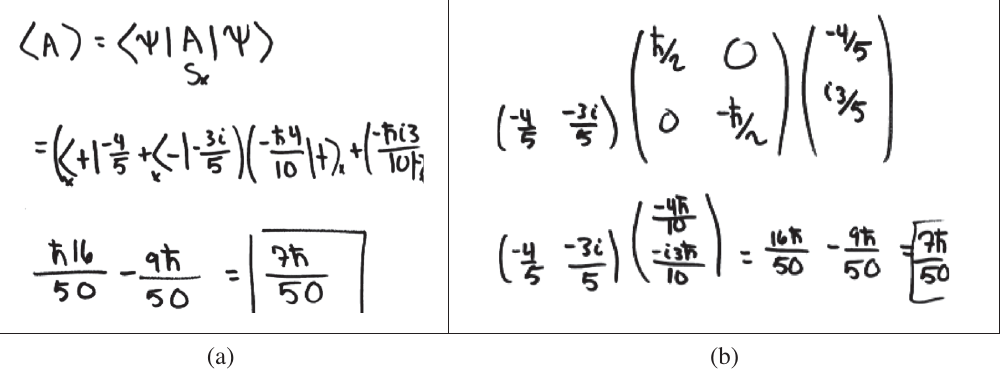
FIG. 3. Buzz ’ s expectation value problem work, in Dirac notation (a) and matrix notation